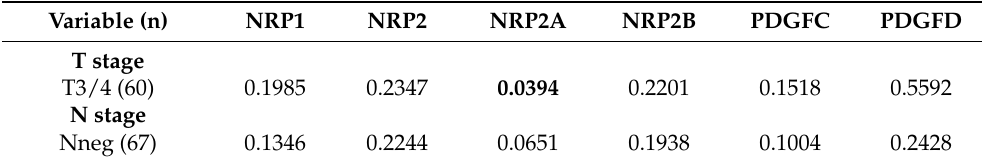
Table 7. Summary of Kaplan–Meier analyses for cancer-specific survival in the Mannheim cohort after stratification for T stage (T2 * vs. T3/4) or lymph node metastasis (Nneg vs. Npos